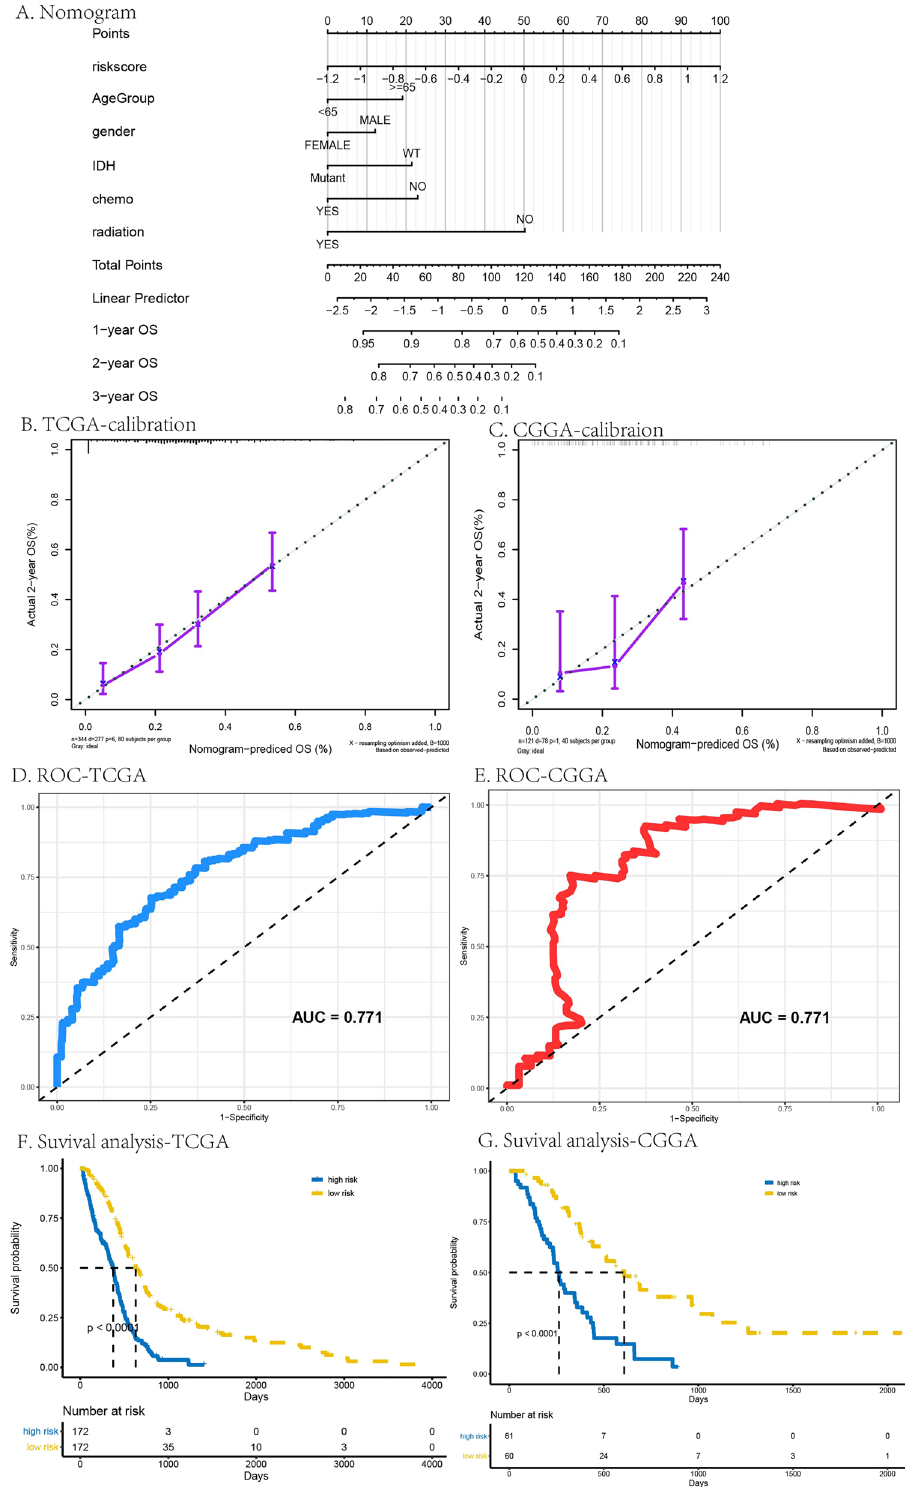
Figure 7. Construction and evaluation of the prognostic composite nomogram. ( A ) the prognostic nomogram to predict the OS probability at 1, 2, and 3 years based on the GBM patients in TCGA and CGGA. ( B , C ) The calibration plots in TCGA ( B ) and CGGA ( C ). ( D , E ) ROC curve analysis of the prognostic nomogram in TCGA ( D ) and CGGA ( E ). ( F , G ) K–M survival curve of the prognostic nomogram in TCGA ( F ) and CGGA ( G ). The p values were shown <